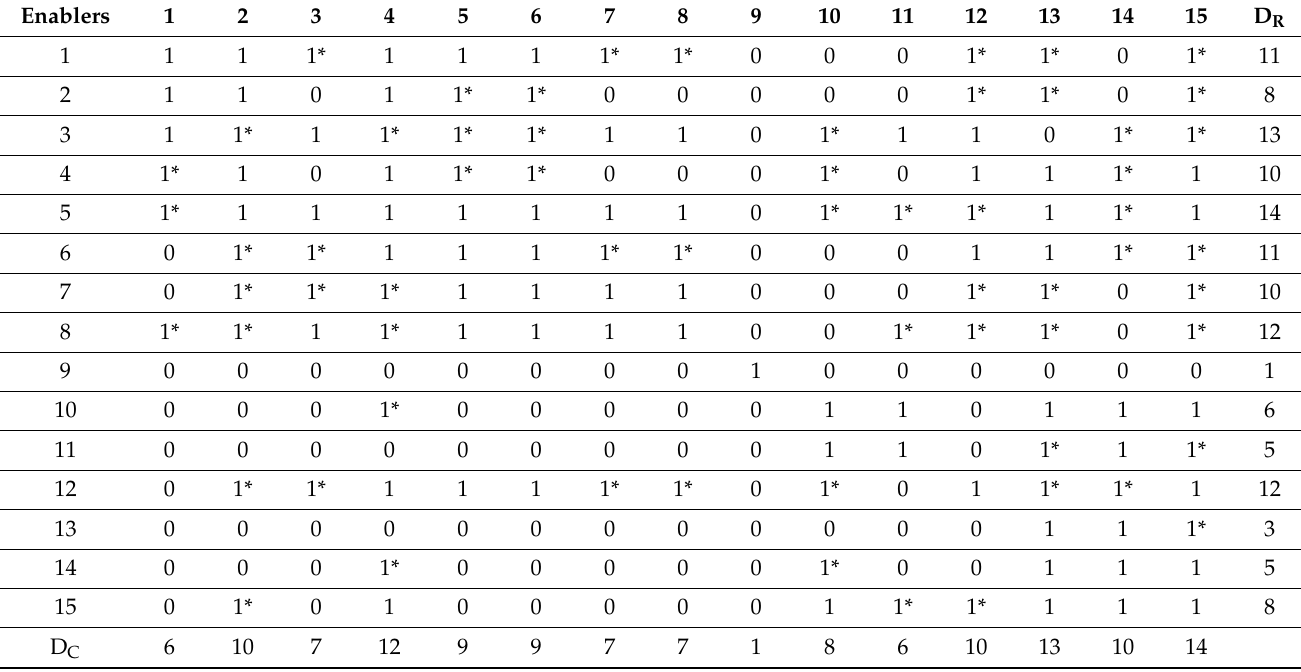
Table 6. Final reachability matrix and D R and D C Values.